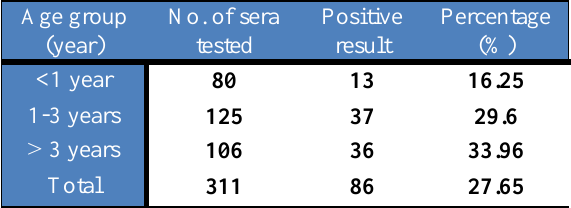
Table, 8: Percentage of sheep and goat brucellosis by using iELISA according to age